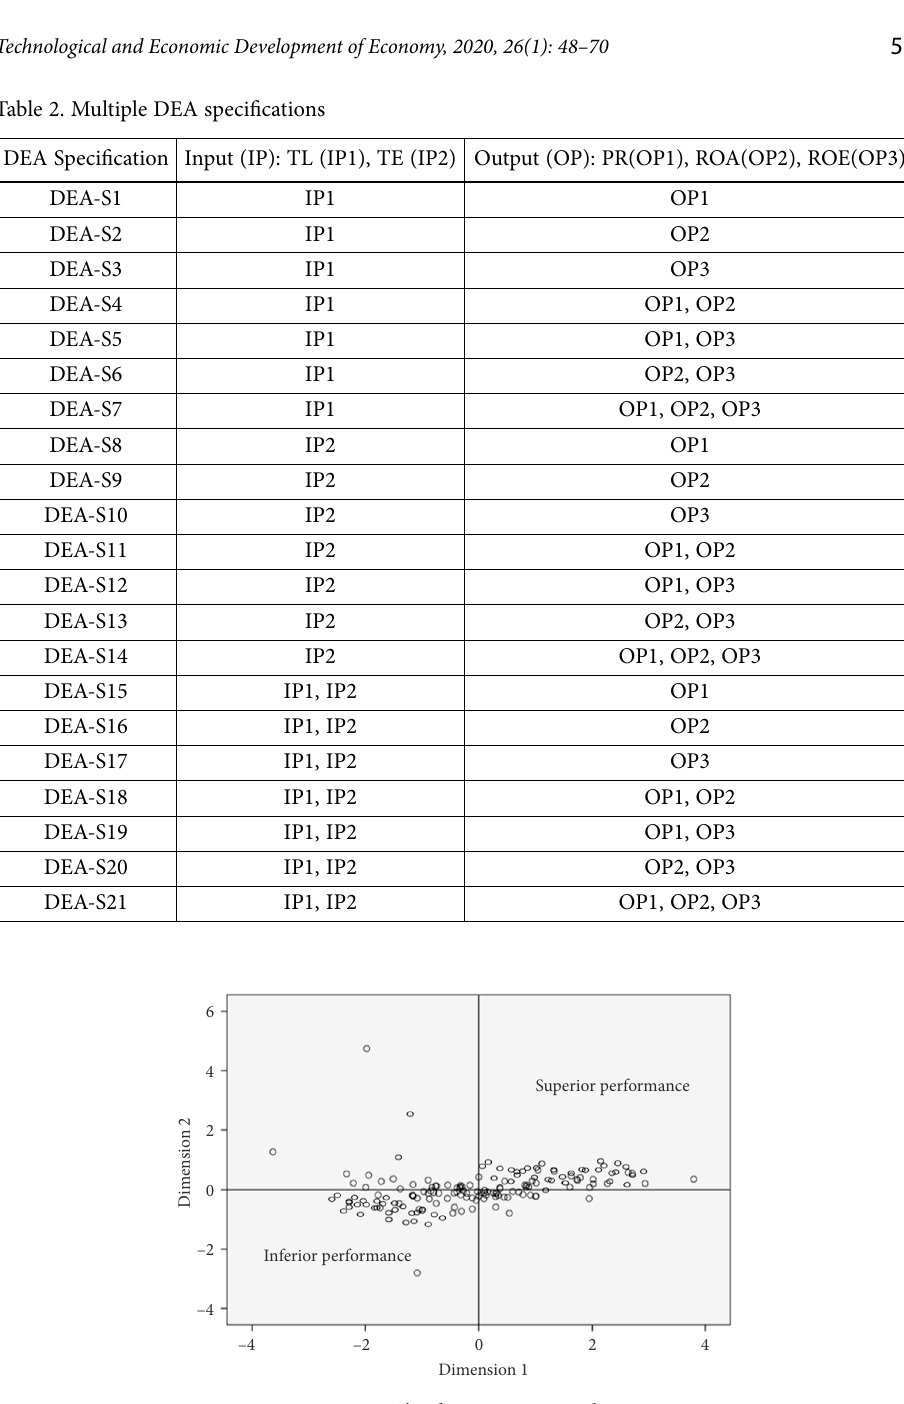
Figure 1. The discriminant